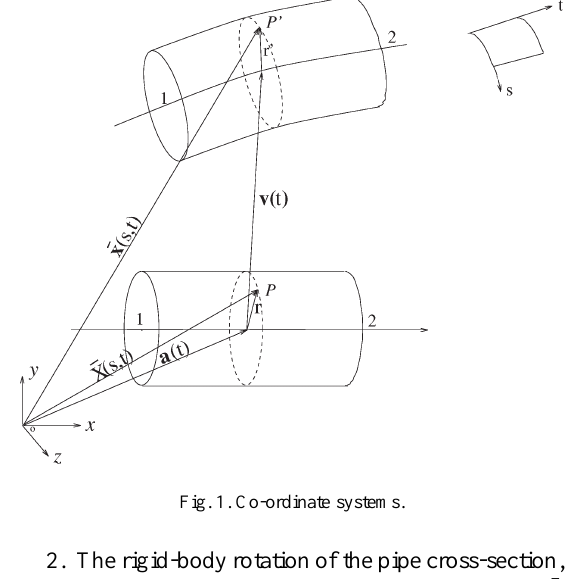
Fig. 1. Co-ordinate